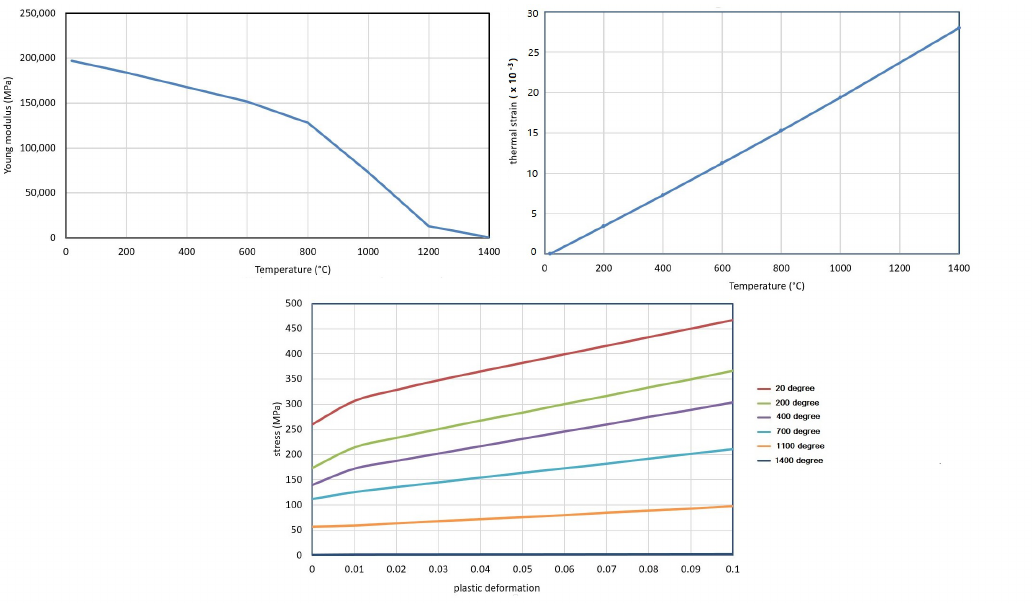
Figure 7. Young’s modulus, thermal strain, and hardening curves of the AISI 316 stainless steel.